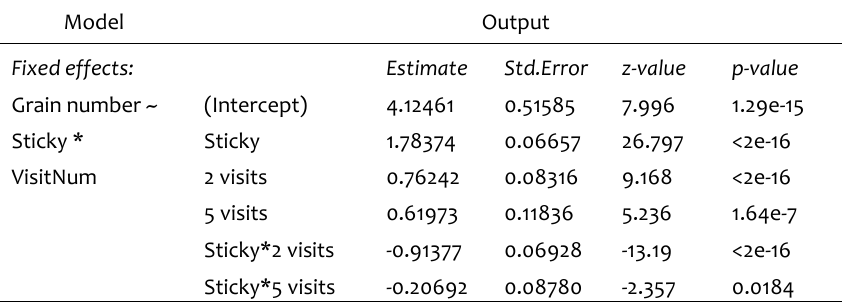
Table 2. Model output for comparisons of number of pollen grains placed on hawkmoth proboscises the between plants with sticky and non-sticky pollen. Previous visits to experimental flowers and testing date were included as random